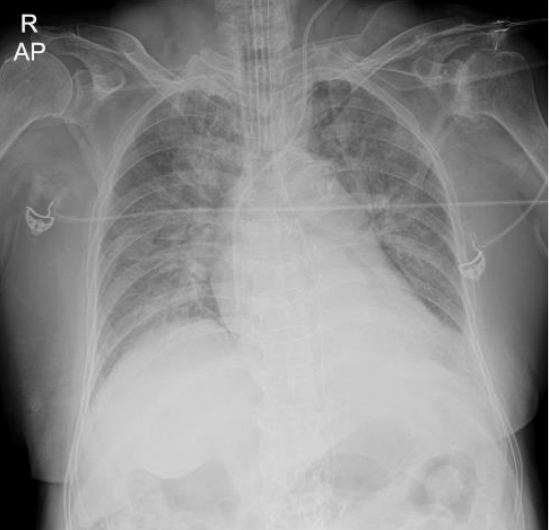
Figure 1. Preoperative chest radiography. Both lung field consolidations, indicating pulmonary edema, were demonstrated.